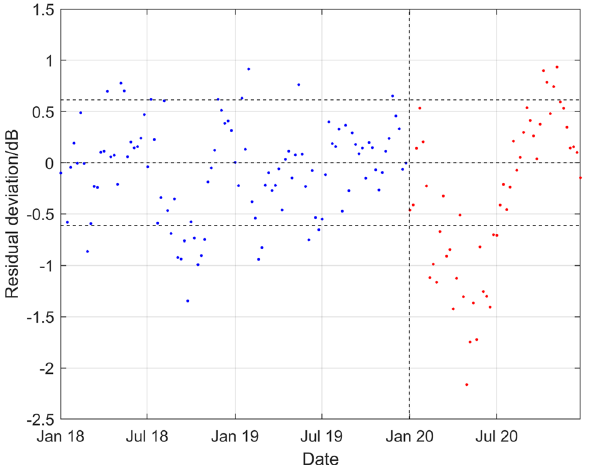
Figure 5. For the period January 2018 to December 2019 and during 2020, deviations of the observed weekly SPSDL data from the predicted values of the long-term and medium-term seasonal components of the GP that define the predictable part of the signal shown in Fig.